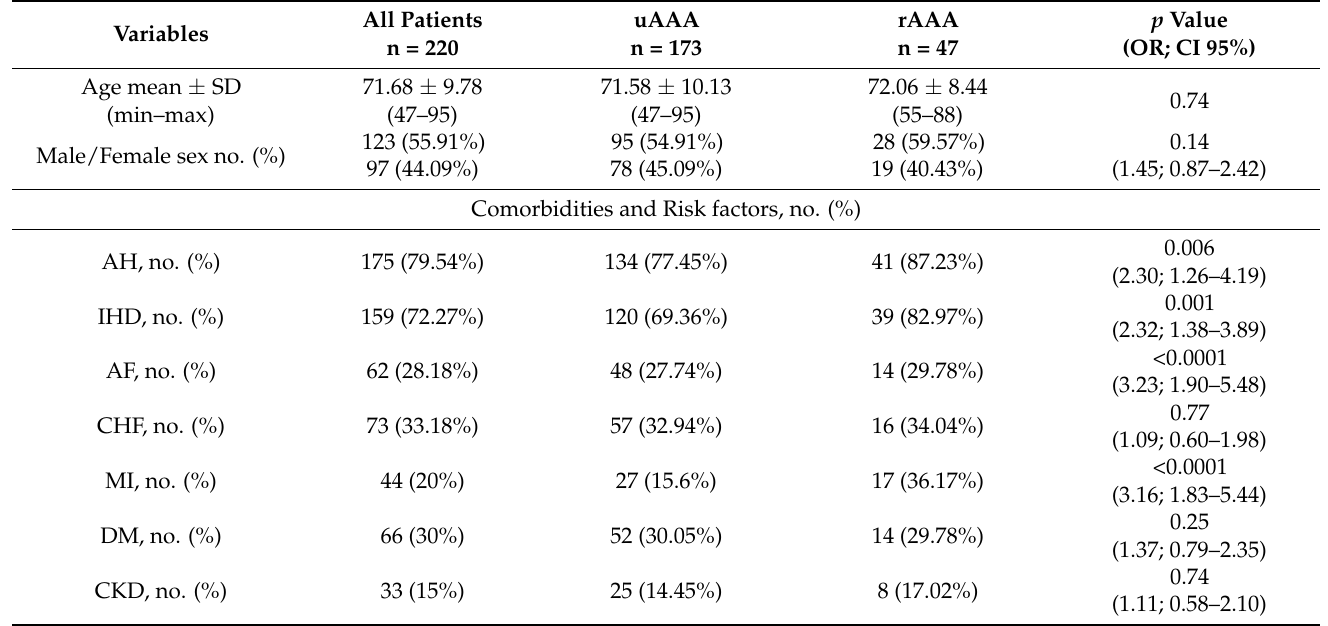
Table 2. The baseline characteristics data of all patients, divided according to the AAA rupture